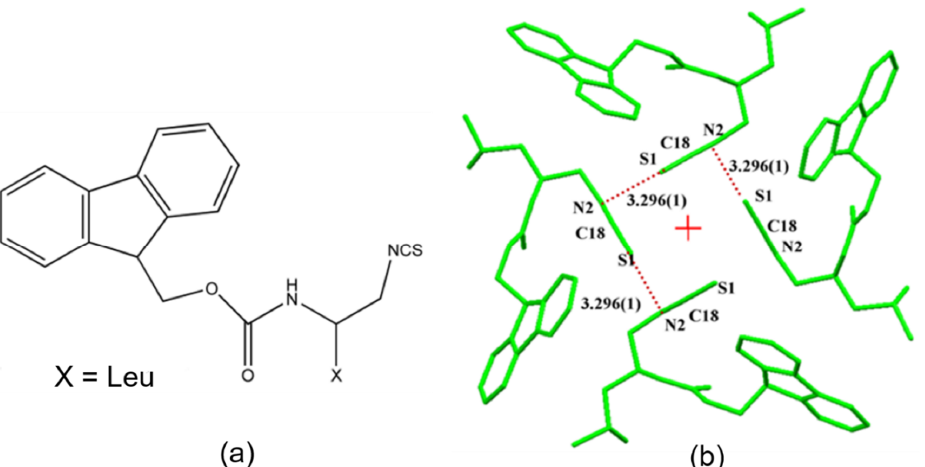
Figure 18. ( a ) Structural formula of F moc -Leu- ψ [CH 2 NCS], ( b ) N=C=S ··· N=C=S interaction motif present in the low temperature (100K) crystal form. ‘+’ in red represents the 4 1 screw axis. (Figure reproduced from reference [90]).